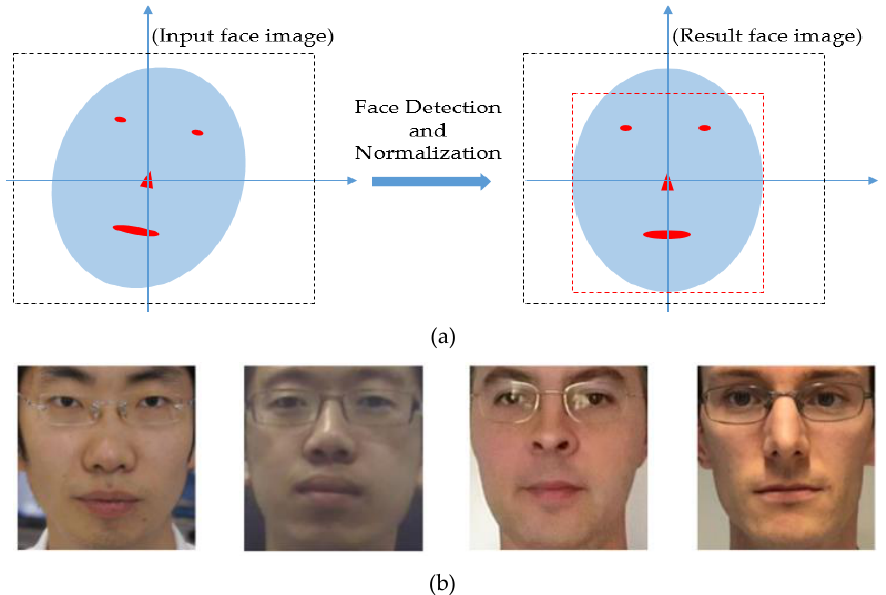
Figure 2. Methodology and an example result of face detection and misalignment compensation steps: ( a ) overview of method for face detection and in-plane rotation compensation with input captured face image (left) and result image (right); ( b ) example